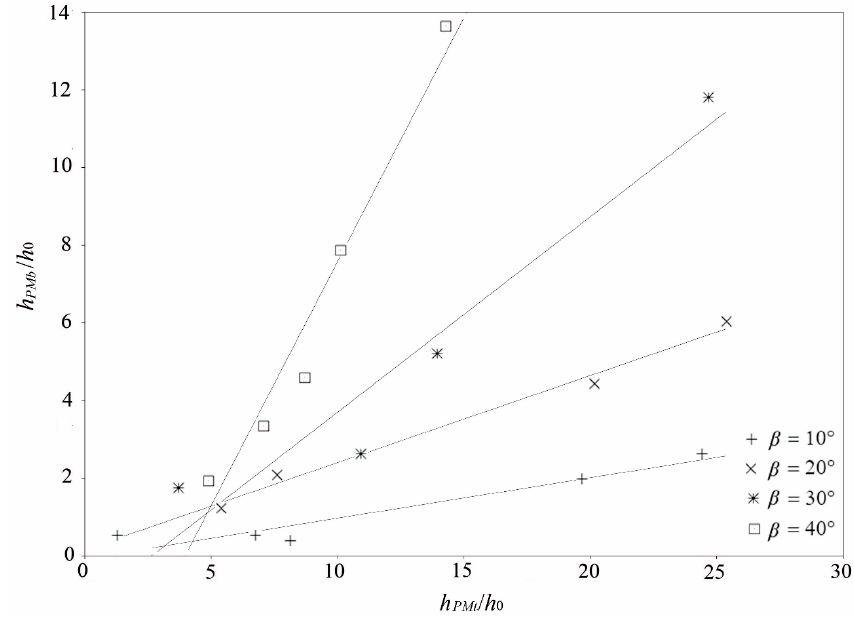
Figure 10. Chart of correlation lines between values of the nondimensional maximum dynamic pressure head acting on tailwater h PMt / h 0 and nondimensional maximum dynamic pressure head acting on bucket h PMb / h 0 for the simulations with R = 0.10 m.